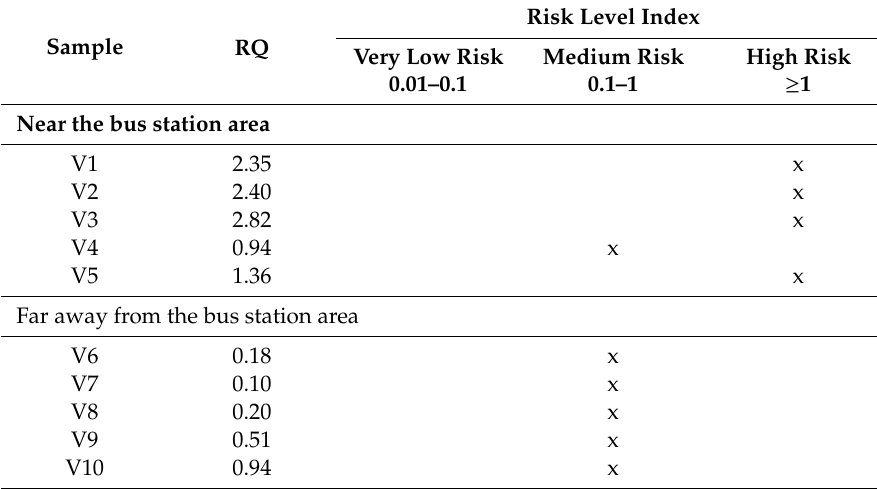
Figure 4. Lead concentrations of samples from vegetables planted in land near ( left ) and far away ( right ) from the bus station. Table 1. Risk quotient (RQ) indexes calculated from vegetable